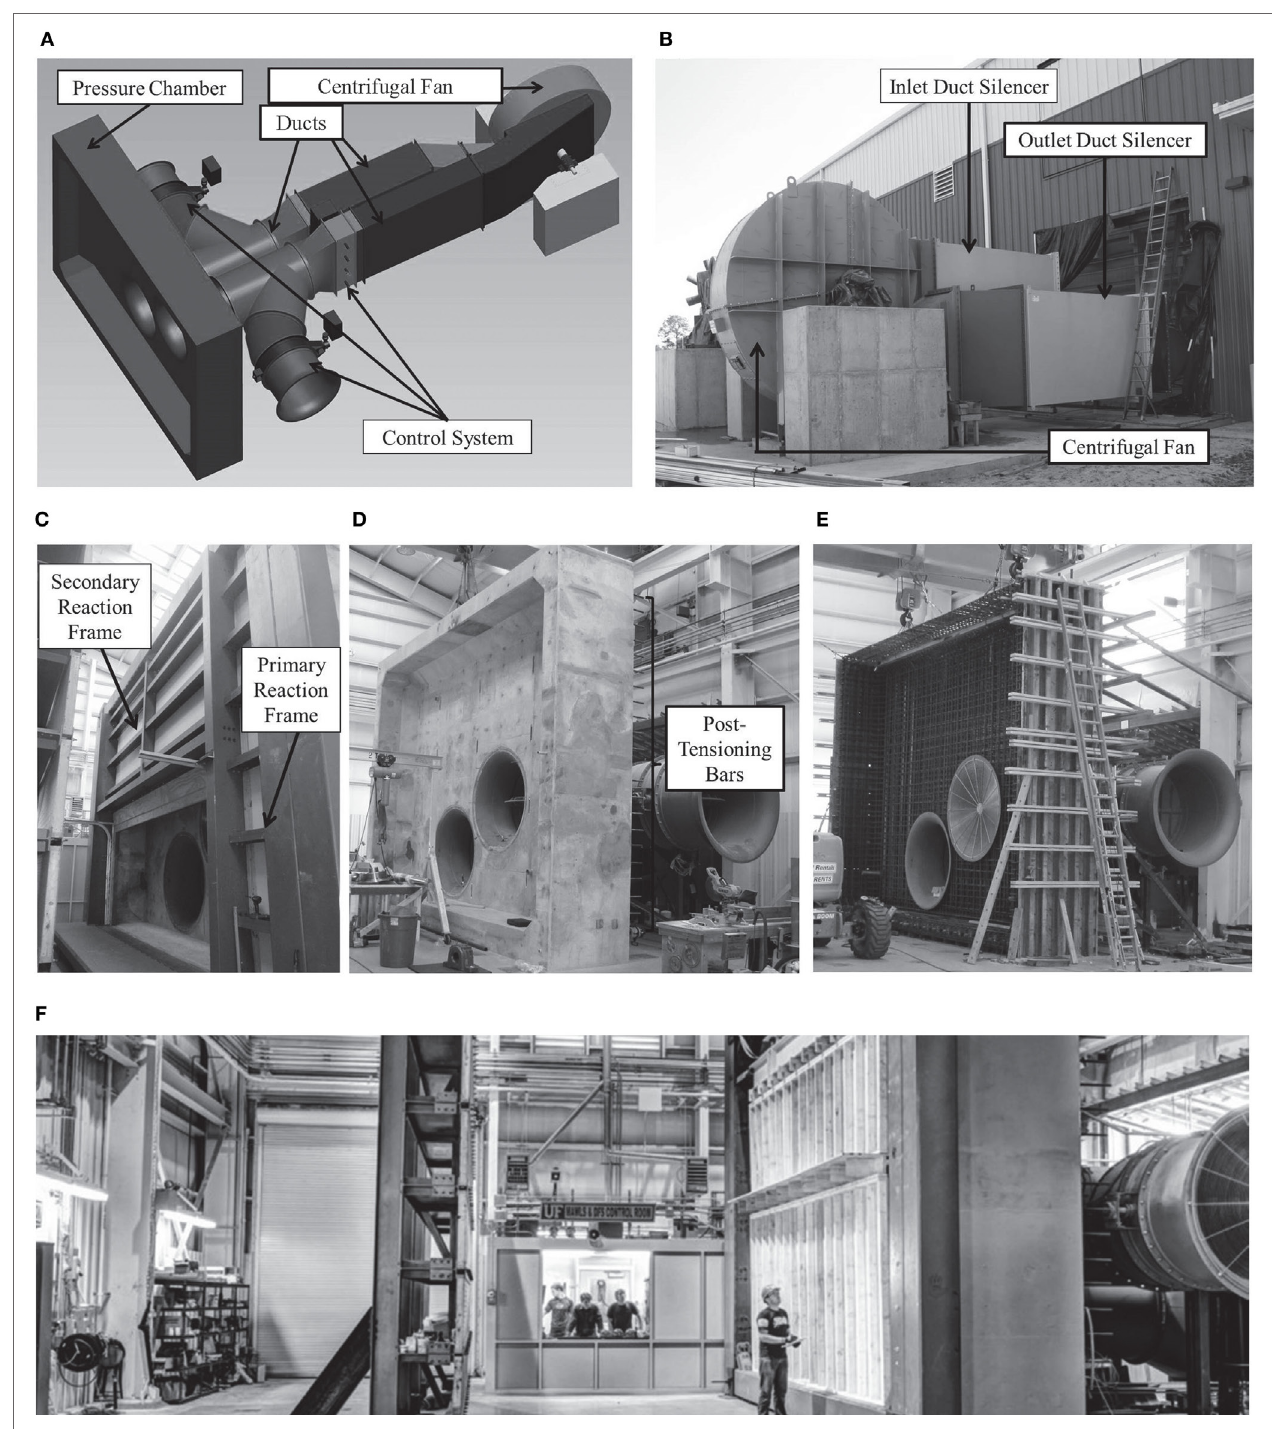
FigUre 1 | The new large-scale dynamic wind pressure simulator: (a) 3D rendering of the simulator; (B) fan system and duct silencers; (c) reaction frame system; (D) pressure chamber; (e) steel reinforcement; and (F) specimen preparation in the pressure chamber with the impact wall free-standing to the left